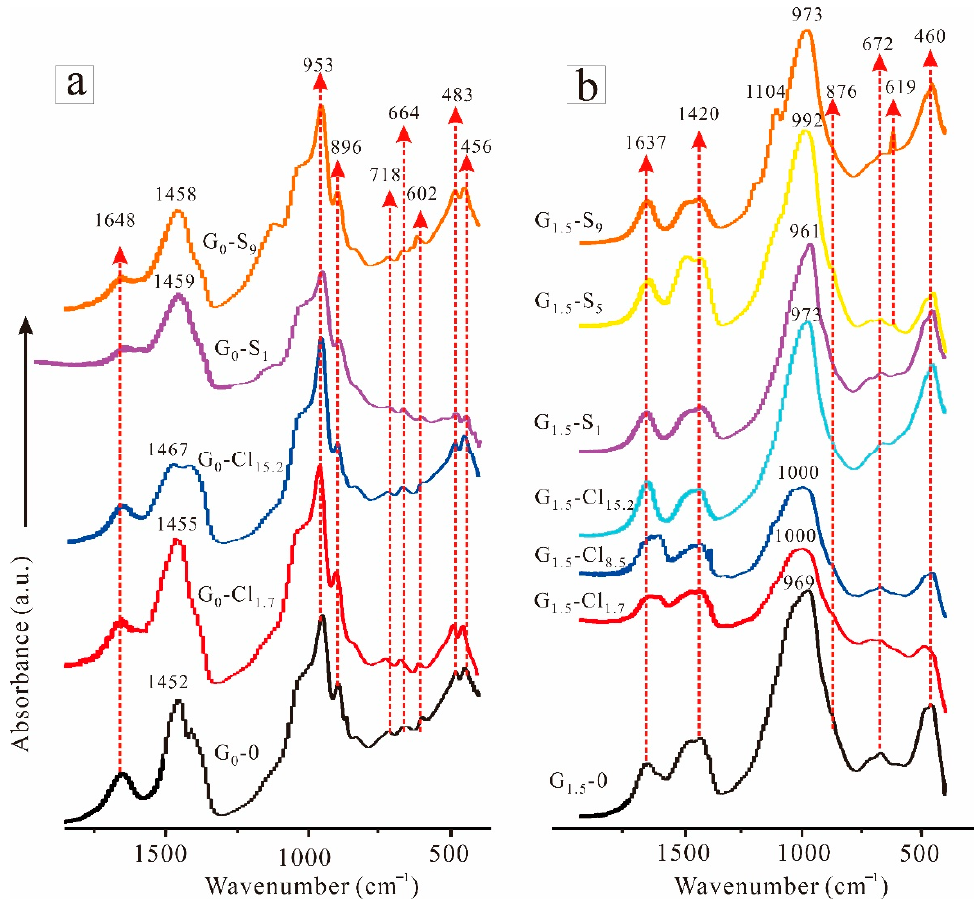
Figure 6. FTIR spectra of ( a ) NaOH-activated and ( b ) Na 2 SiO 3 -activated geopolymers.